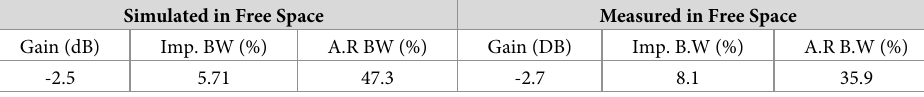
Table 3. A comparison of the simulated and observed findings was carried out in free space at 2.45 GHz. Simulated in Free Space